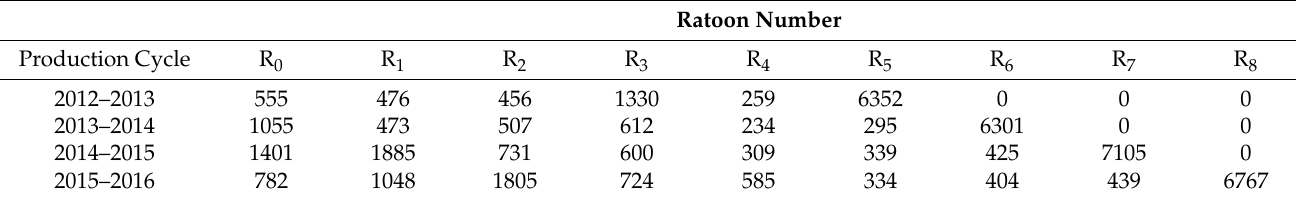
Table 2. Number of plots having the R i ratoon in each production cycle. Ratoon